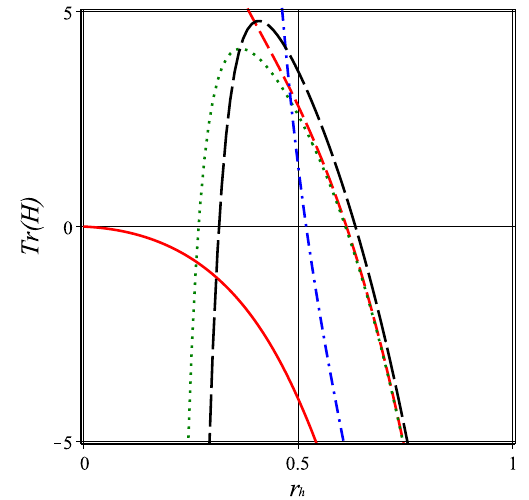
Fig. 3 Hessiantraceintermsof r h .Wesetunitvaluesforallparameters in the model except θ = 1, d = 8. α = 0 . 5, γ 1 = 0 ( red dash ), α = 0 . 5, γ = − 0 . 02 ( green dot ), α = 0, γ 1 ( blue dash dot ), α = 0 . 5, γ 1 = − 0 . 1, γ 2 = 0 . 5 ( black long dash )